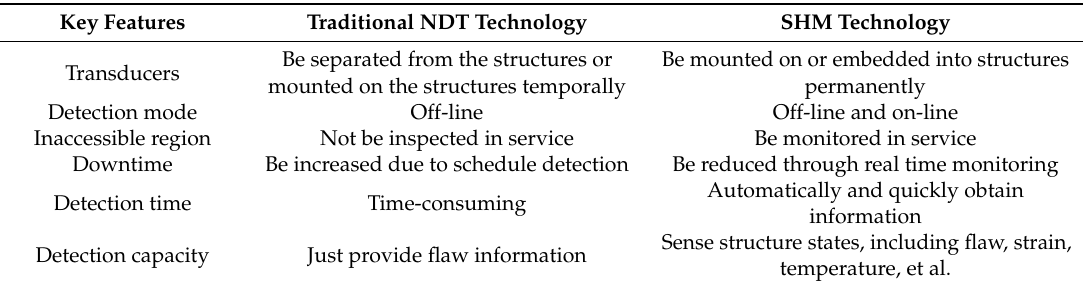
Table 1. Comparison of traditional NDT and SHM technologies.